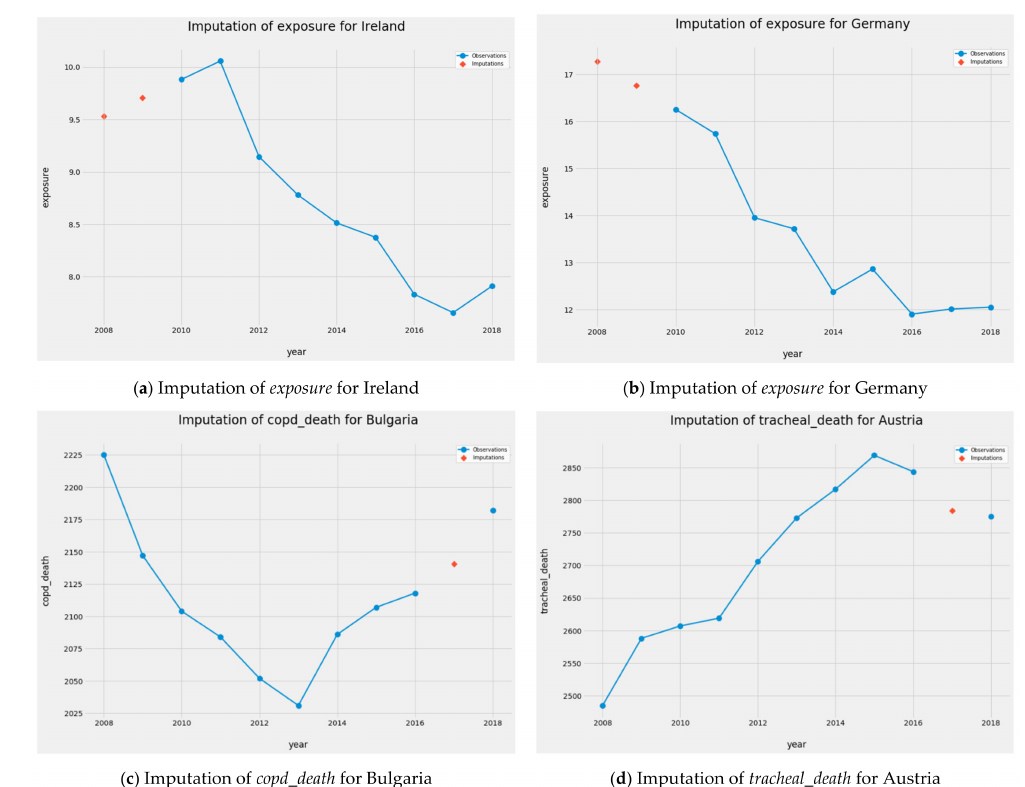
Figure A1. Imputing missing values for exposure , copd_death , and tracheal_death using LOESS and linear or cubic splines.